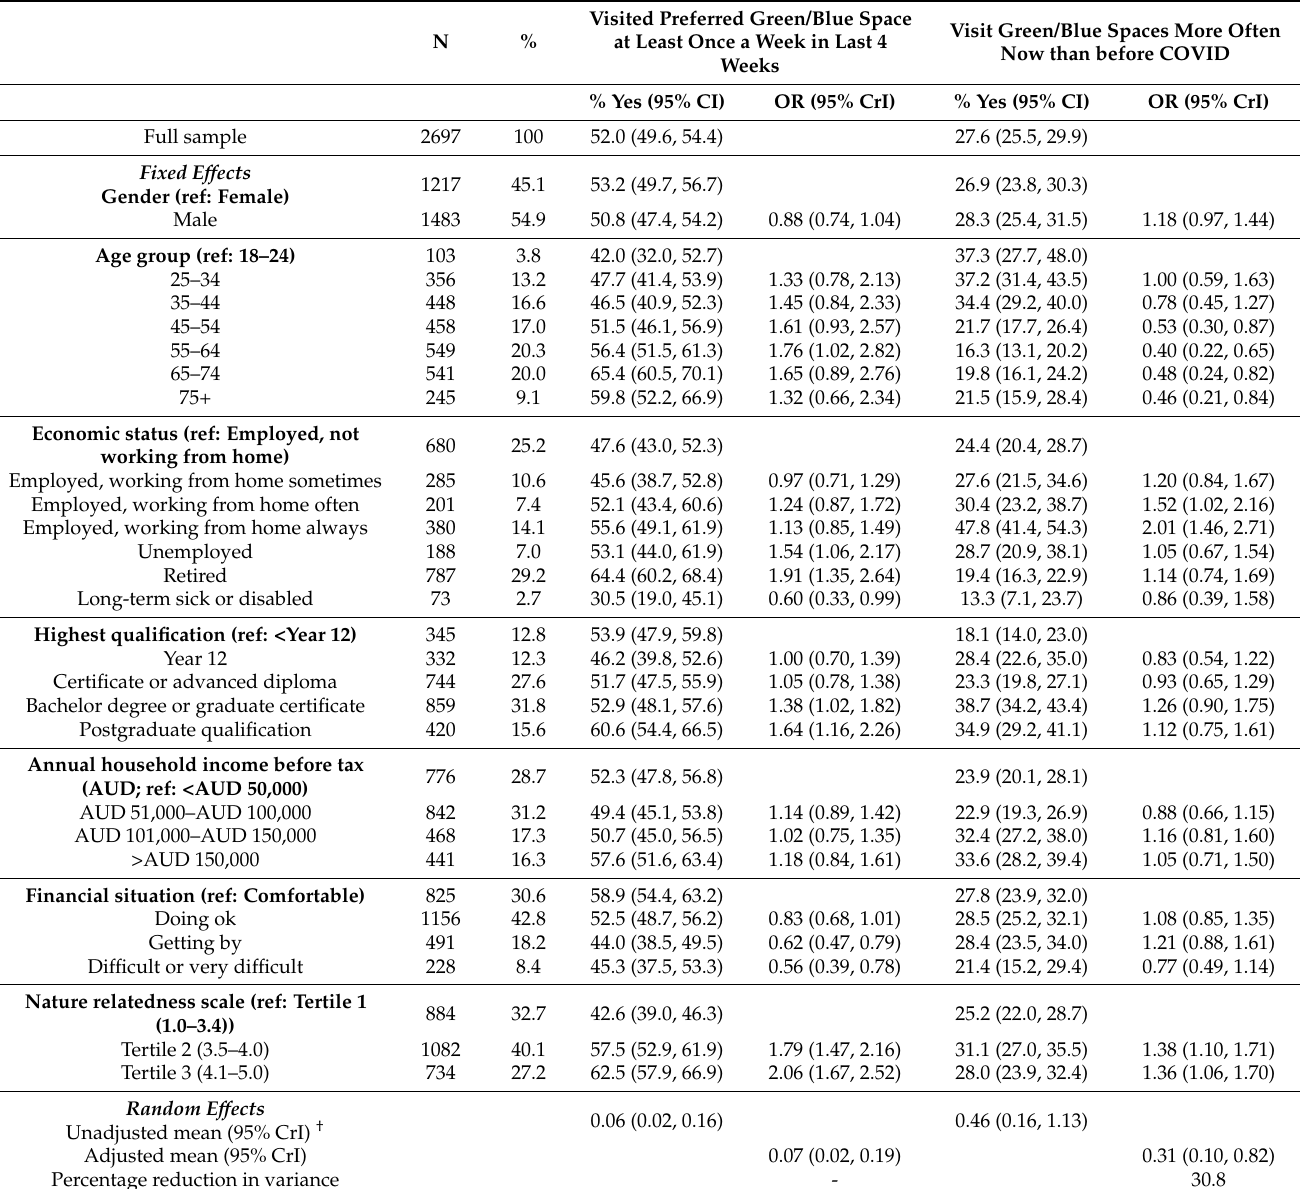
Table 4. Associations with visits to green or blue spaces during the COVID-19 pandemic. Visited Preferred Green/Blue Space Visit Green/Blue Spaces More Often N % at Least Once a Week in Last 4 Now than before COVID Weeks % Yes (95% CI) OR (95% CrI) % Yes (95% CI) OR (95%